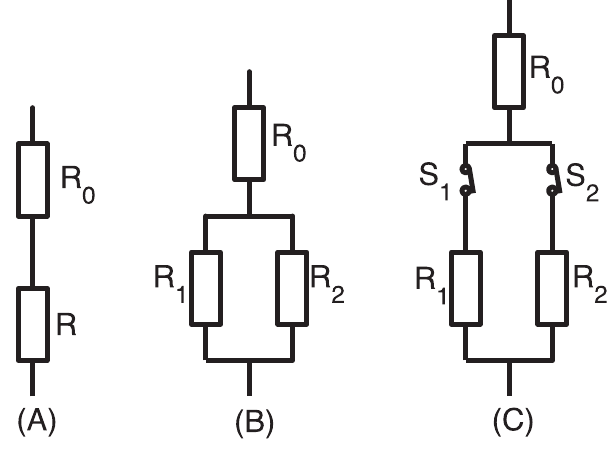
Figure 1. Illustration of simple systems in the vessel network. The icons are borrowed from the electrical circuit [30]. (A) A vessel is in series with a fixed resistance R 0 . (B) The parallel part of two vessels is in series with a fix resistance. (C) The parallel part is controlled by the open-close switches.